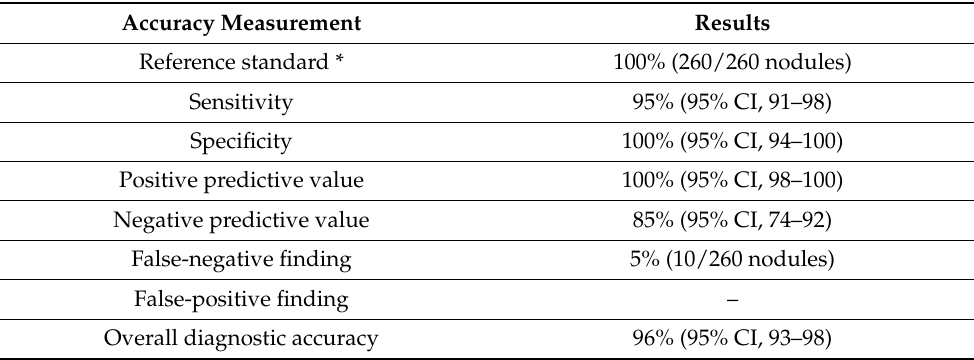
Table 3. Accuracy of CEUS for the diagnosis of spleen involvement by lymphoma on 260 nodules analyzed in the